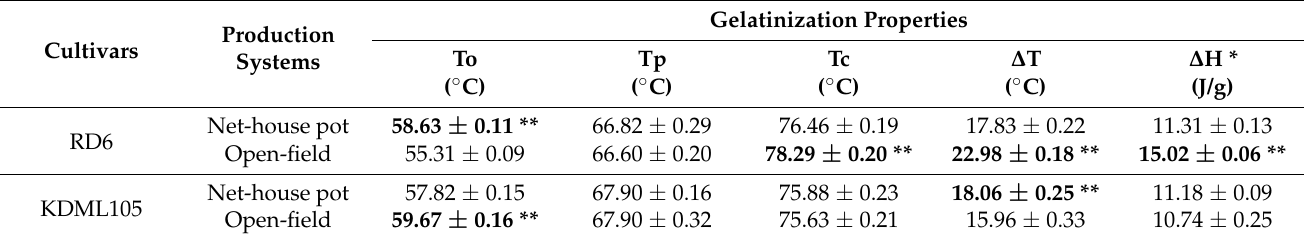
Values are means ± SEM. Means in bold within each column with the ** symbol denote statistically significant difference between the two production systems at p ≤ 0.01 by Student’s t -test ( n = 4). Abbreviations: SP = swelling power; S = solubility; To = onset temperature; Tp = peak temperature; Tc = conclusion temperature; ∆ T = temperature range (Tc–To); and ∆ H = gelatinization enthalpy. * Dry weight basis. Table 8. Retrogradation properties of starches from the two elite Thai rice cultivars grown in the net-house pot and open-field production systems.